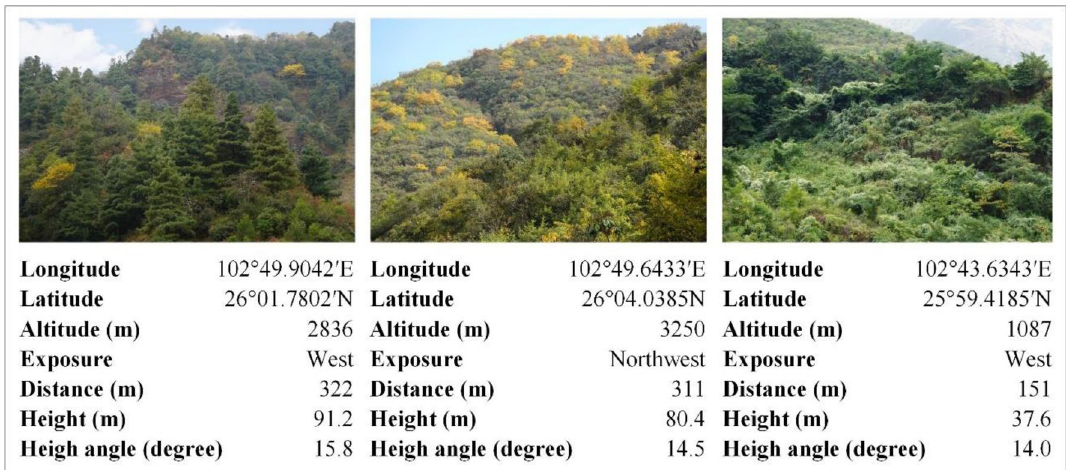
Figure 2. Representative photos of target forests taken at the observation points. Distance and height are between an observation point and its targeted forest area. The height angle is the angle between the horizontal plane and the line of direction from an observation point to the center of the target slope